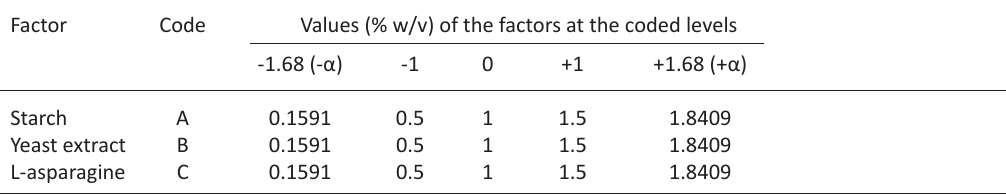
Table 2. Independent factors and their levels in the three-factor and five-level CCD Factor Code Values (% w/v) of the factors at the coded levels -1.68